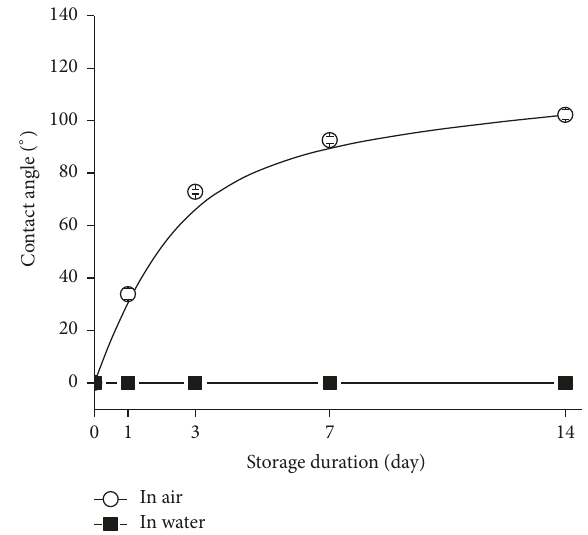
Figure 4: The changes of contact angles with increasing storage duration.